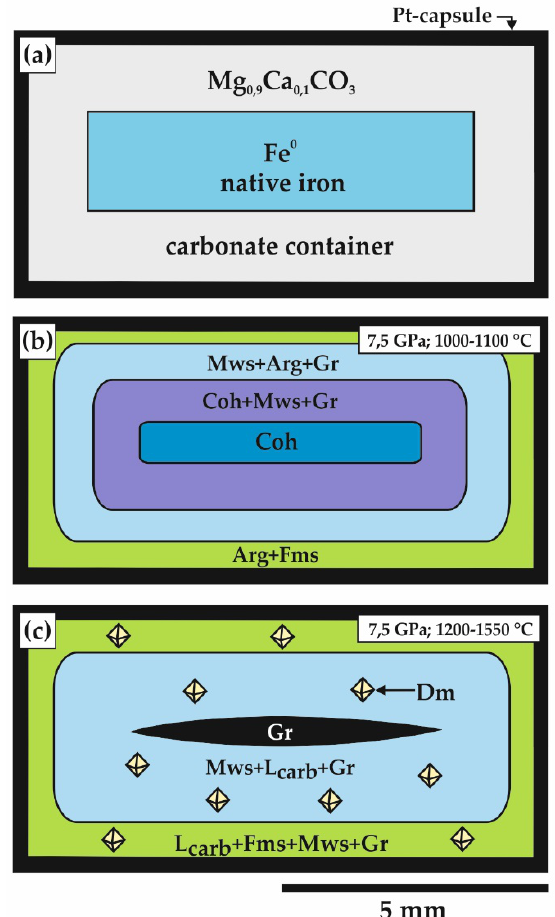
Figure 2. A scheme of an initial ampoule assembly ( a ) and schemes of ampoules after experiments on carbonate-metal interaction at 7.5 GPa and 1000–1100 °C ( b ) and 1200–1550 °C ( c ); Coh: cohenite, Mws: magnesiowustite, Arg: aragonite, Gr: graphite, Fms: ferromagnesite, Dm: diamond, L carb : predominantly carbonate melt.